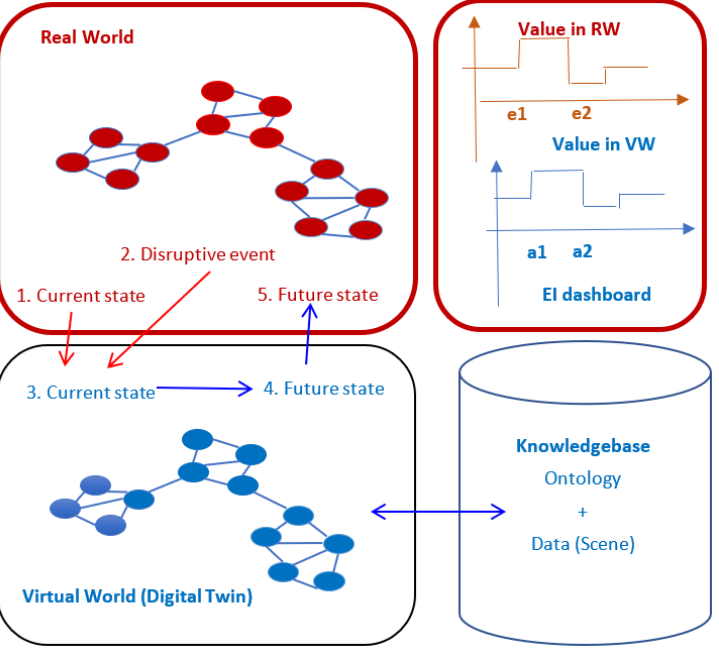
Figure 1. The relations between real world and digital world of digital ecosystem.